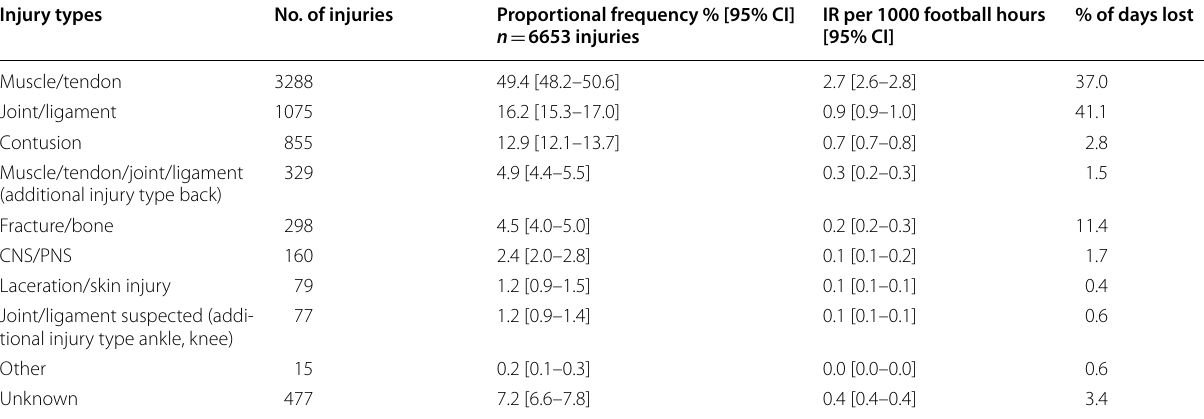
CI confidence interval; IR injury incidence rate; CNS/PNS central/peripheral nervous